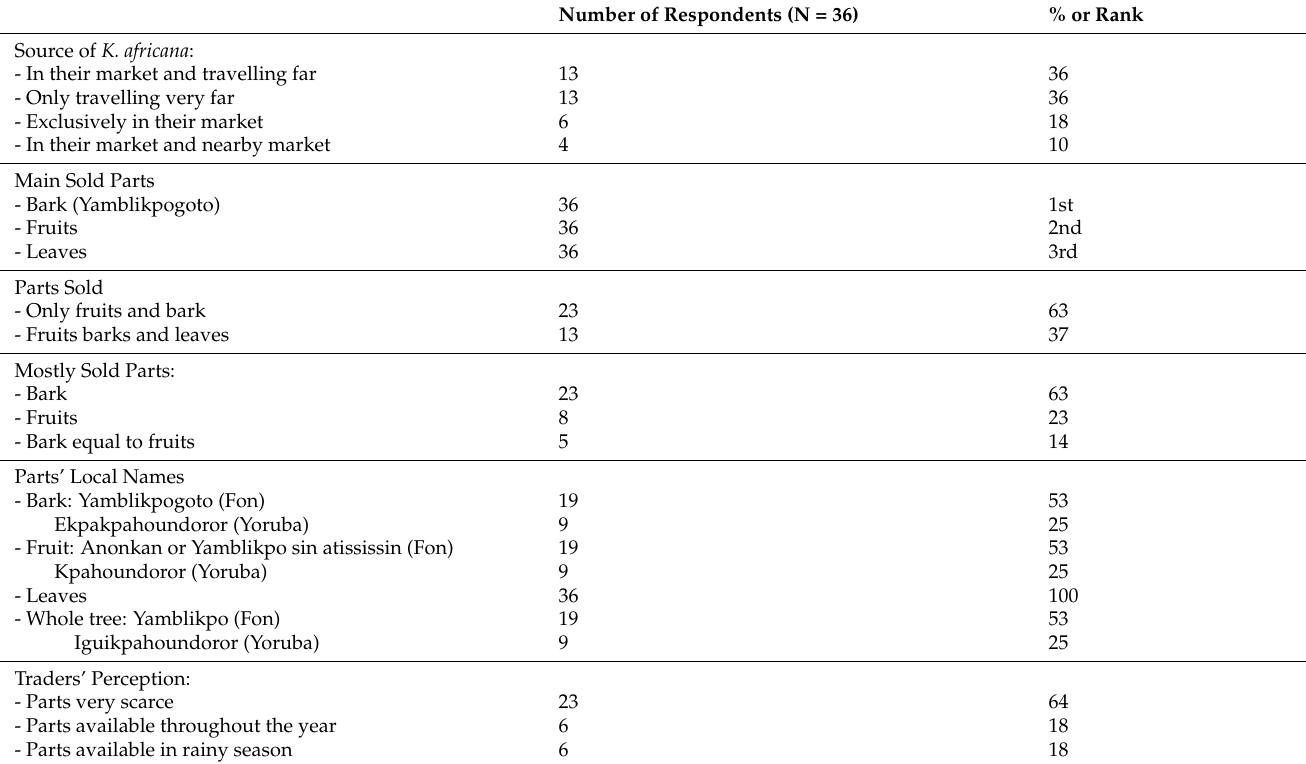
Table 3. K. africana parts, source, sold, local names, and traders’ perception from the interviews. Number of Respondents (N = 36) % or Rank